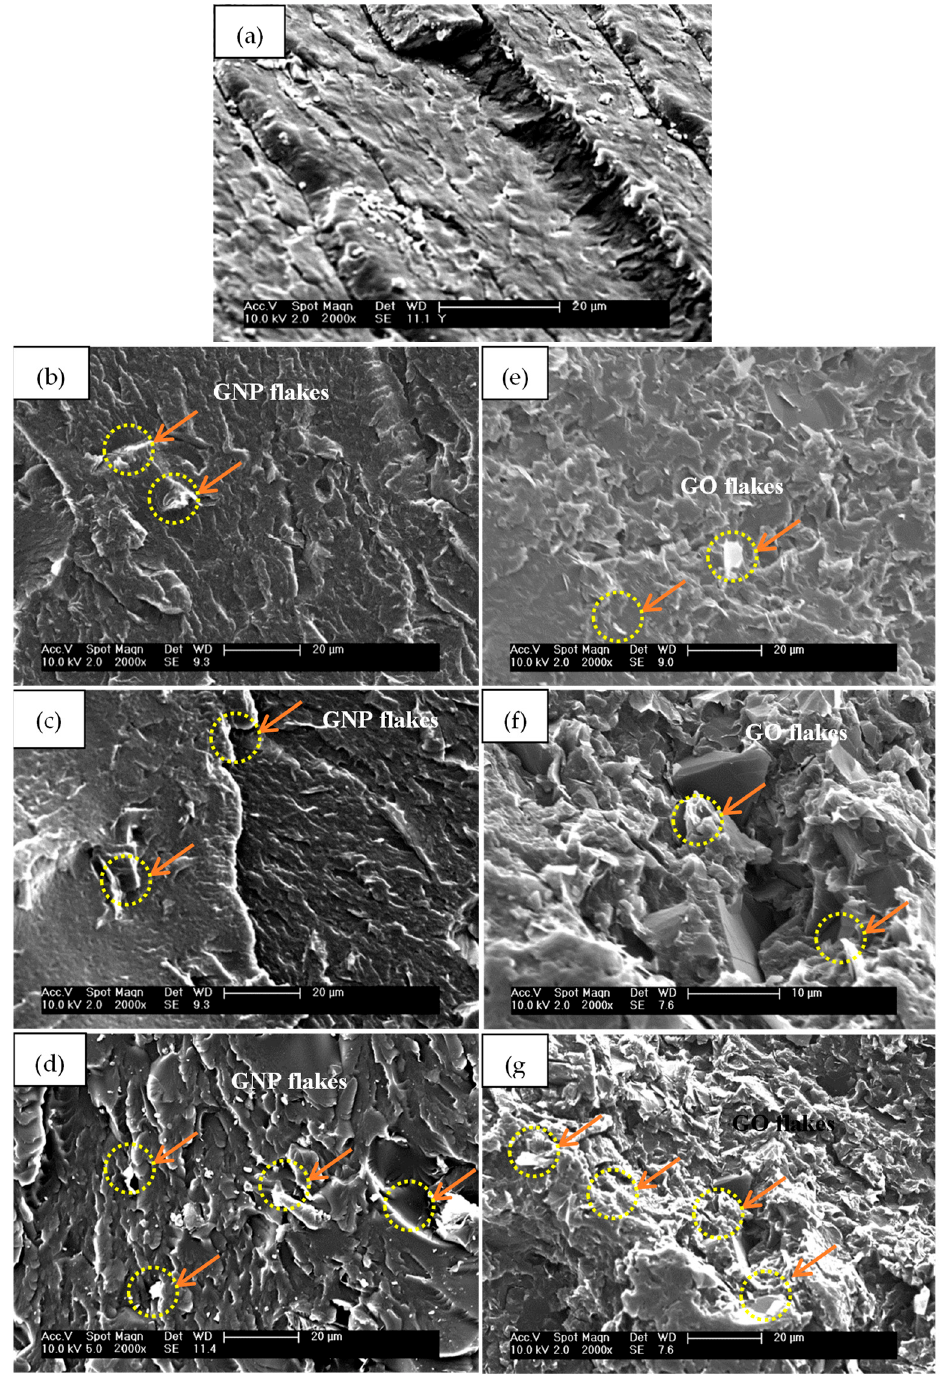
Figure 8. SEM images of cryogenic-fracture surfaces of ( a ) pure PU, ( b – d ) PU/GNP, and ( e – g ) PU/GO nanocomposites with loadings of GNP and GO of 0.25 wt. %, 0.5 wt. %, and 0.75 wt. %, nanocomposites with loadings of GNP and GO of 0.25 wt.%, 0.5 wt.%, and 0.75 wt.%, respectively.